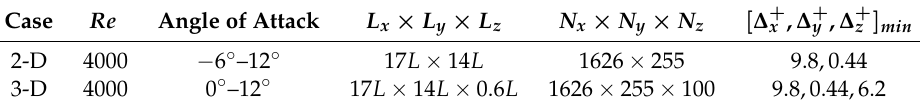
Table 1. Computational parameters. (The superscript + means the wall